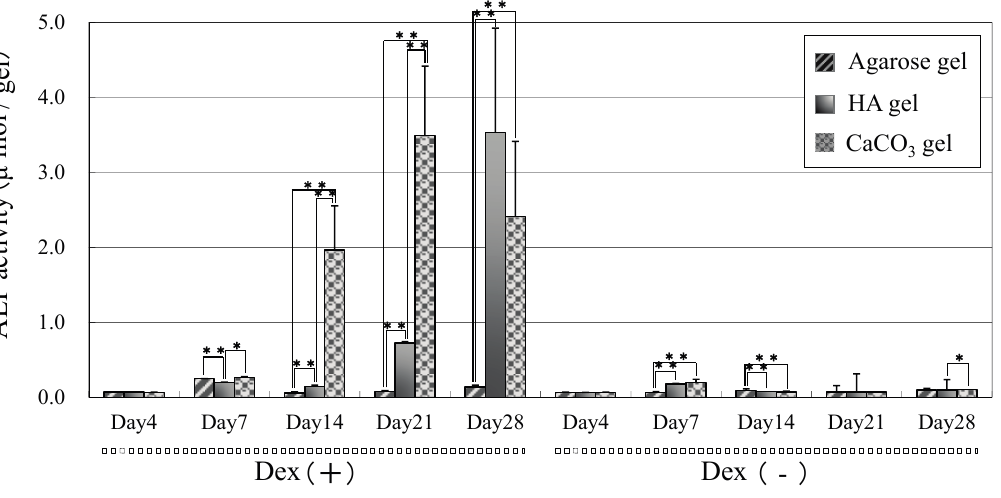
Figure 5. ALP activity of MSCs cultured in the presence (Dex (+)) or absence (Dex ( − )) of dexamethasone on agarose, HA/agarose, and CaCO 3 /agarose gels. Cultures were performed for 4 to 28 days. The data represent means ± SD ( n = 6). * p < 0.05, ** p < 0.01.